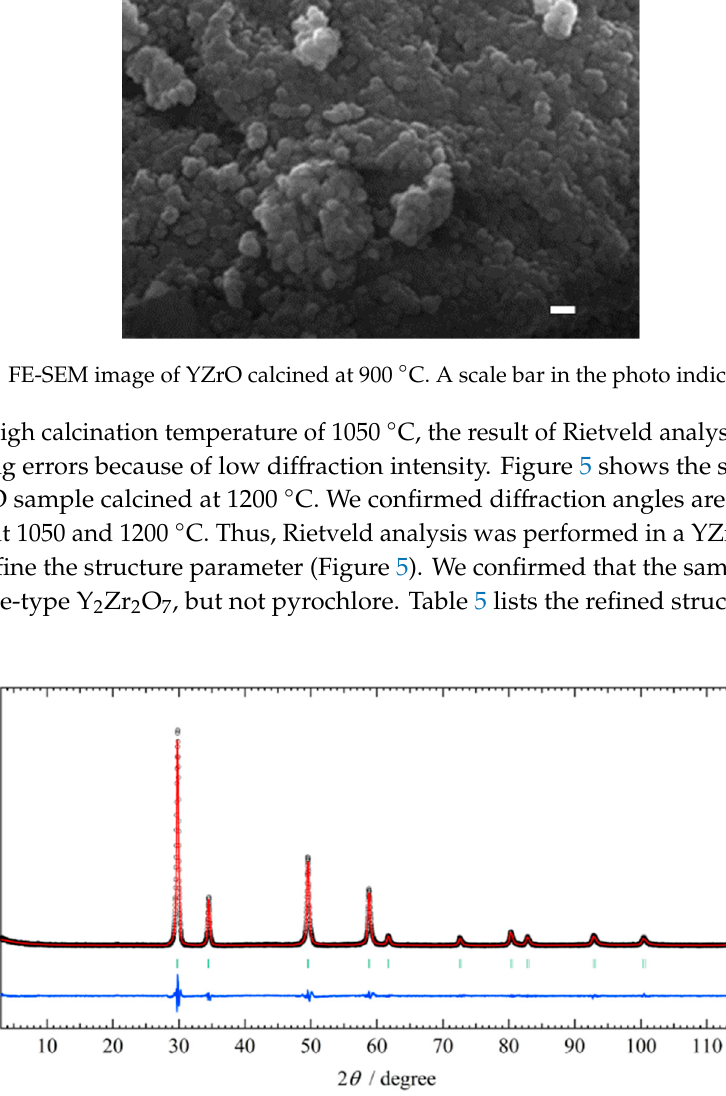
Figure 5. Step-scanning XRD pattern of YZrO calcined at 1200 ◦ C with calculated XRD pattern. Black points and red lines represent observed and calculated patterns, respectively. Green vertical marks indicate the Bragg reflection positions of defected-fluorite Y 2 Zr 2 O 7 phase. Blue line at the bottom shows the difference between the observed and calculated patterns (For interpretation of the references to color in this figure legend, the reader is referred to the web version of this article). Table 5. Refined structure parameters of Y 2 Zr 2 O 7 and YZrO calcined at 1200 °C. Sample